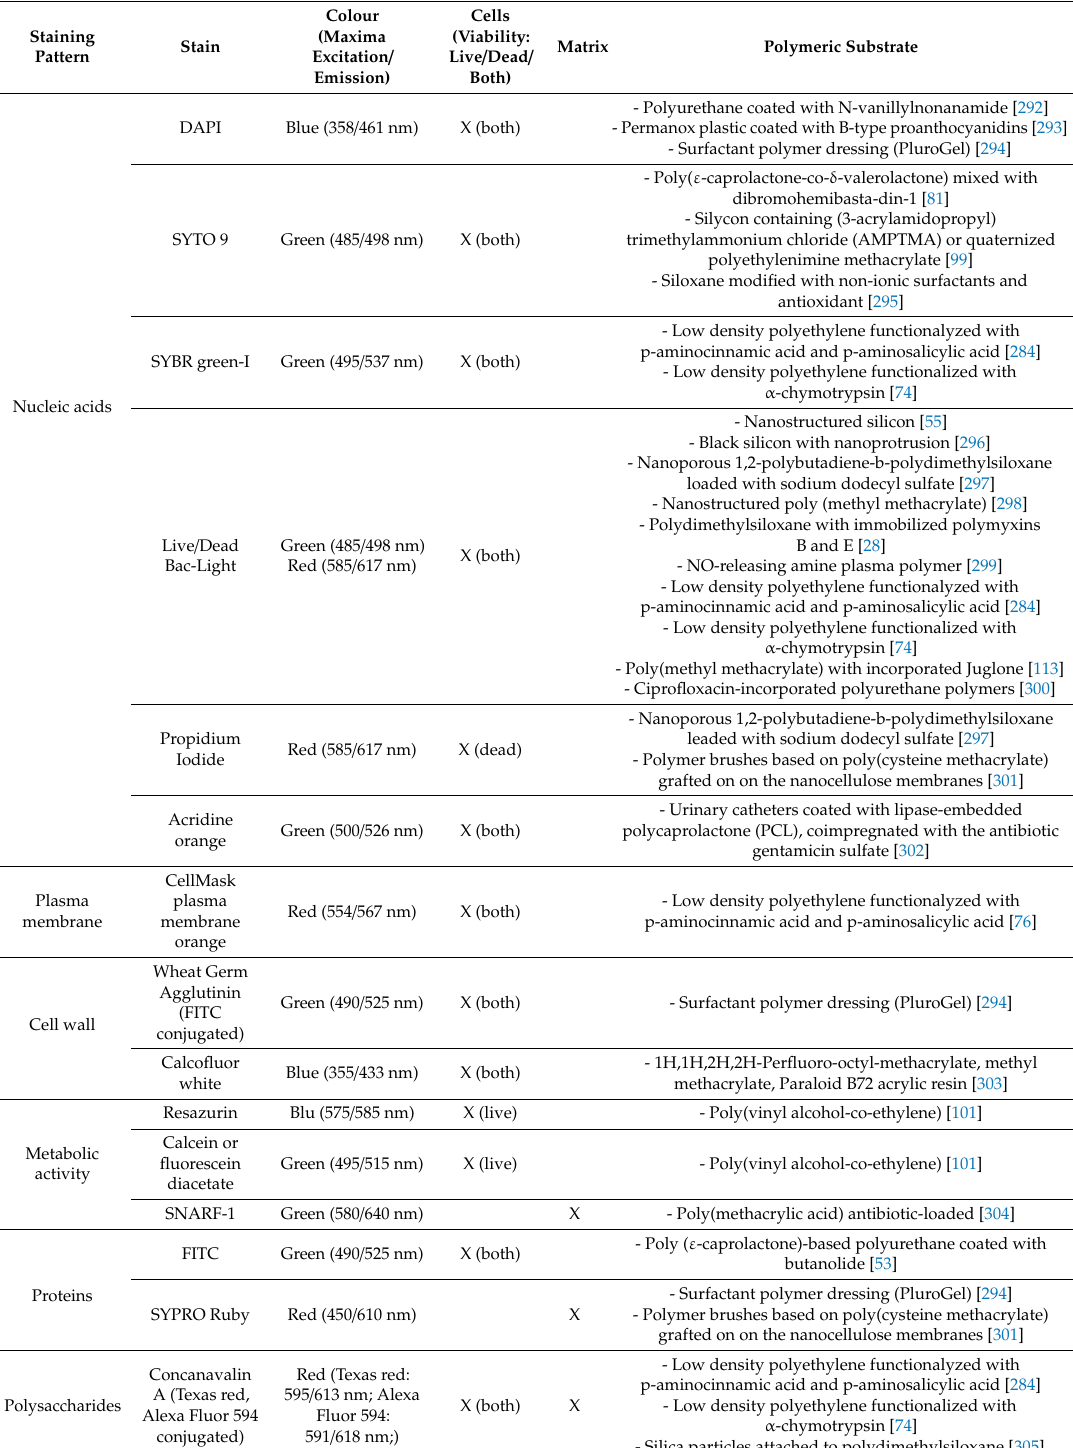
Table 3. Examples of the most common fluorescent stains used for staining biofilm grown on polymeric surfaces with anti-biofilm